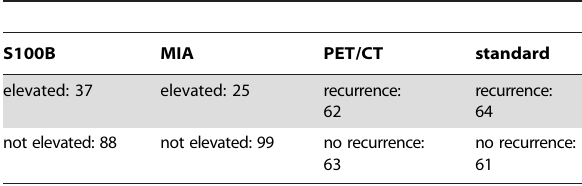
Table 2. Patients positive or negative for recurrent/metastata- sized melanoma in PET/CT, S100, MIA and standard of reference.